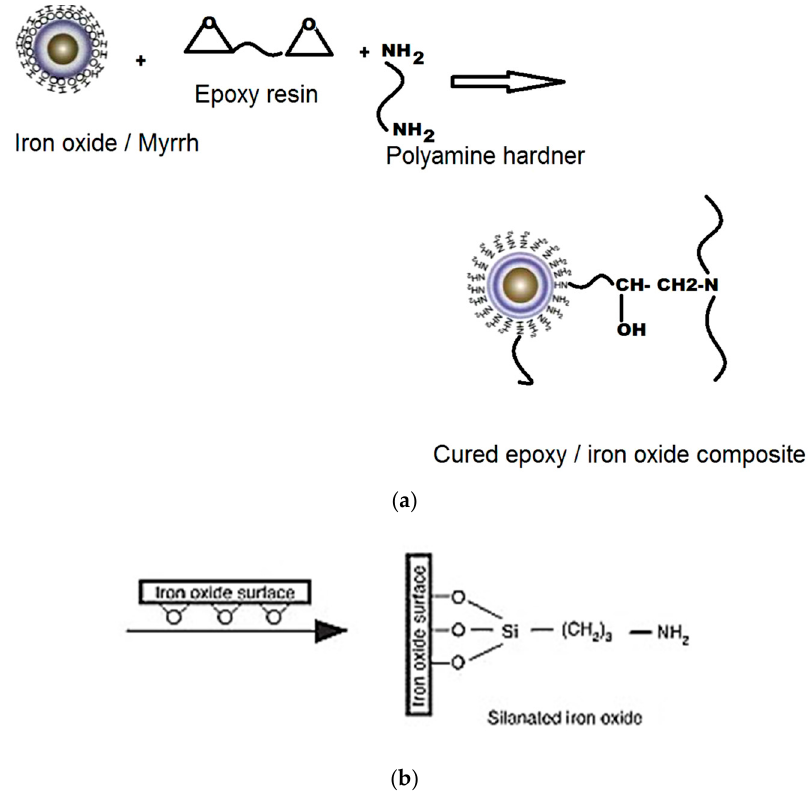
Figure 14. ( a ) Interfacial chemical bonding between iron oxide and the epoxy resin. Numbers indicate bond energies (kJ·mol − 1 ) [29]. ( b ) Iron oxide and silicone [83].